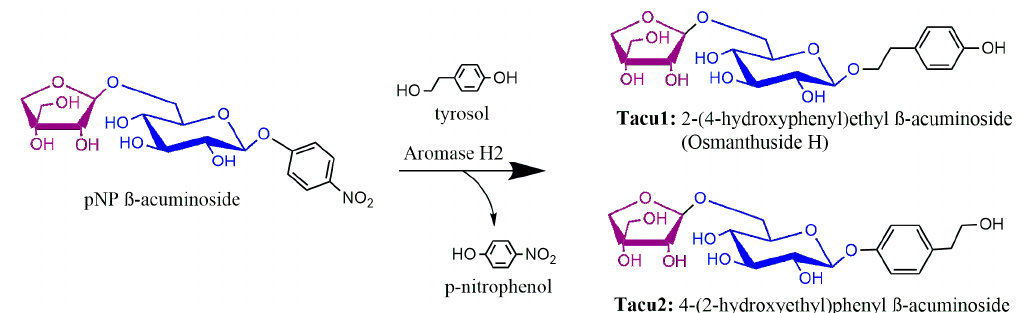
Figure 2. Acuminosylation of tyrosol by Aromase H2.